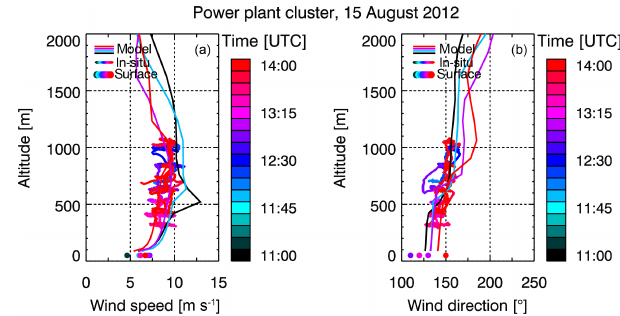
Figure 10. Wind speed (a) and direction (b) as measured from the in situ turbulence probe as well as COSMO-DE model data and sur- face in situ information from Düsseldorf airport about 30km north- north-east of Neurath power plant (obtained from weather under- ground, http://www.wunderground.com).